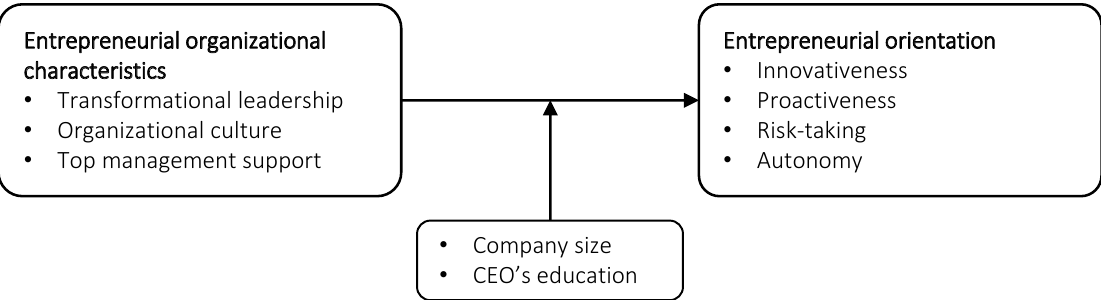
Figure 1. Conceptual